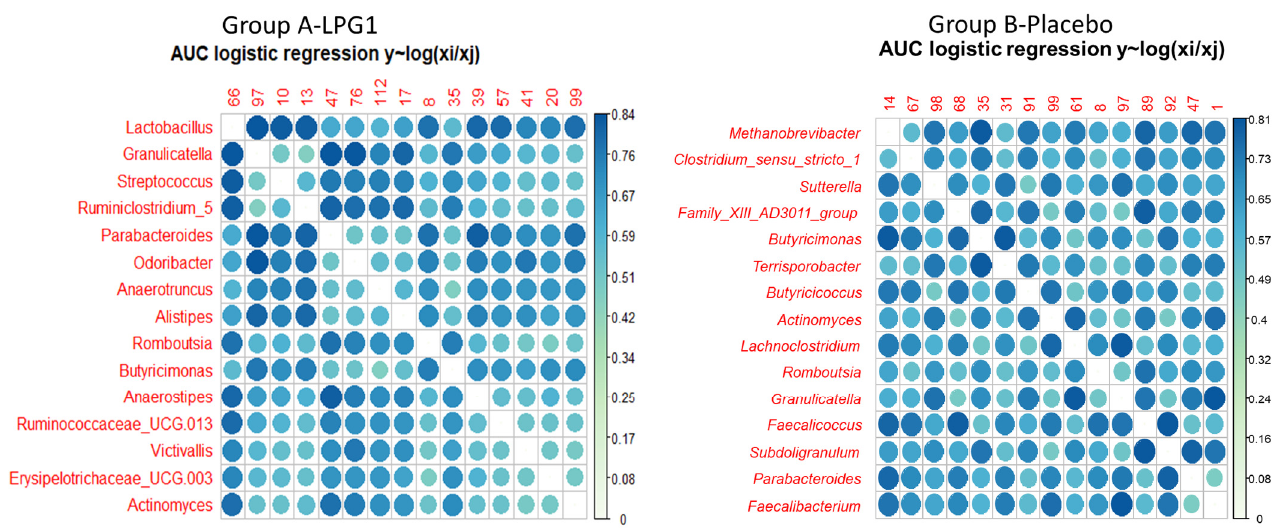
Figure 4. Heat-map-like plot (colour scale on the right) generated from the exploratory analysis of the coda4microbiome R package for the data obtained in the randomised, placebo-controlled, single-blind trial to study the effect of oral intake of L. pentosus LPG1 on the human gut microbiota. The plot displays the most relevant log ratios between ASVs from gut microbiota associated with the response (initial and final trial phases) in A—LPG1 and B—placebo groups. It is worth noticing that the log ratios Lactobacillus vs. Granulicatella , Streptococcus , Anaerostipes , Ruminococaceae UCG-013, or Actinomyces exhibited a high predictive accuracy in A—LPG1, while Lactobacillus did not play any role in B—placebo.